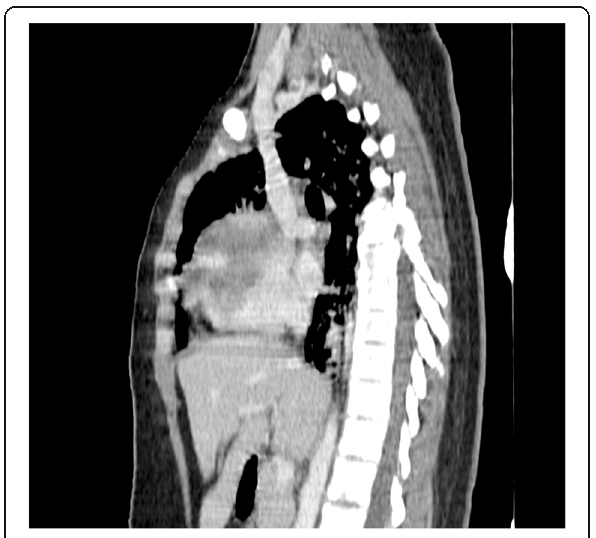
Fig. 2 Sagittal remodeling of the thorax computed tomography in the mediastinal window demonstrating direct atrial injury, invading the superior vena cava